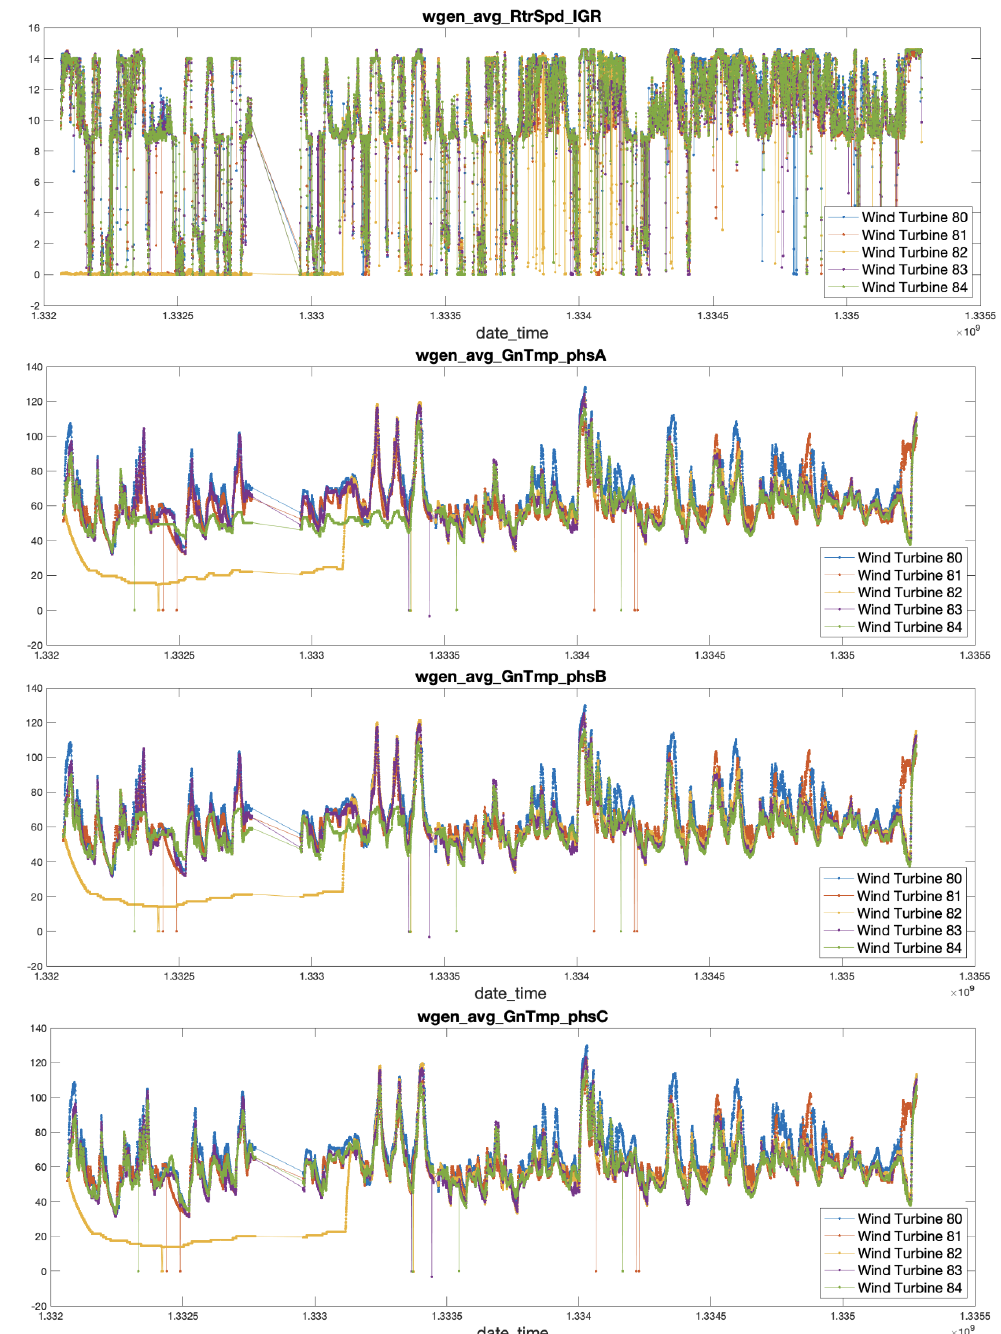
Figure 1. Plot of the pattern of variation of four variables of all the WTs in a common time interval.